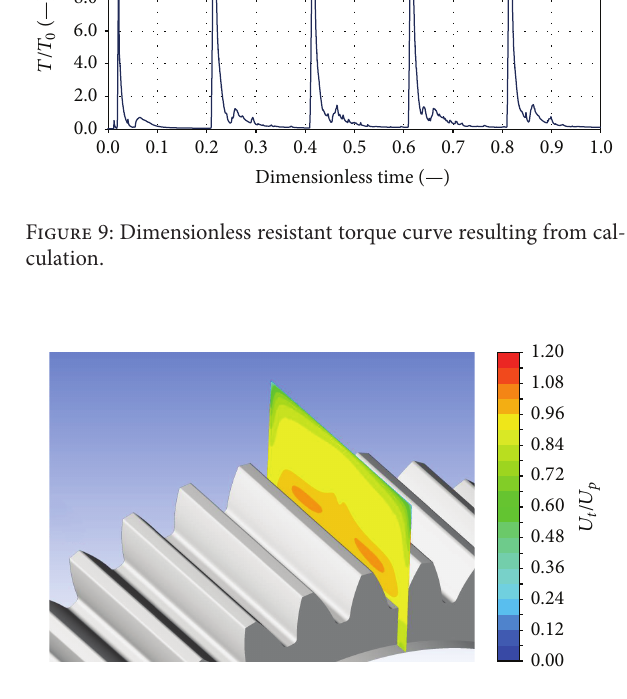
Figure 10: Contour plot of 𝑈 𝑡 /𝑈 𝑝 on the section plane for the reference geometry